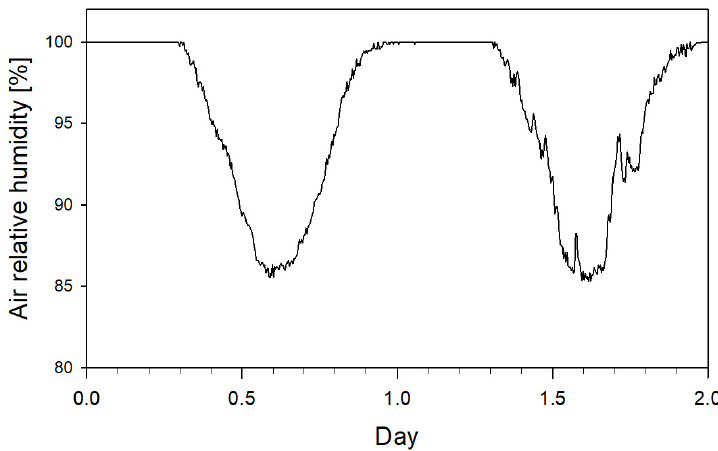
Figure 8. Measured air relative humidity inside the underwater biosphere.